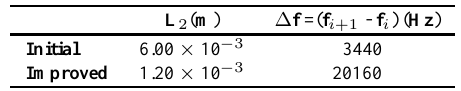
Table 1 Output results from the structural improvement case